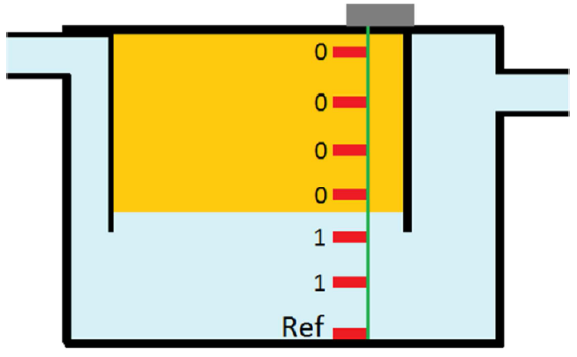
Figure 6. Conductivity probes (in red) in a grease box.